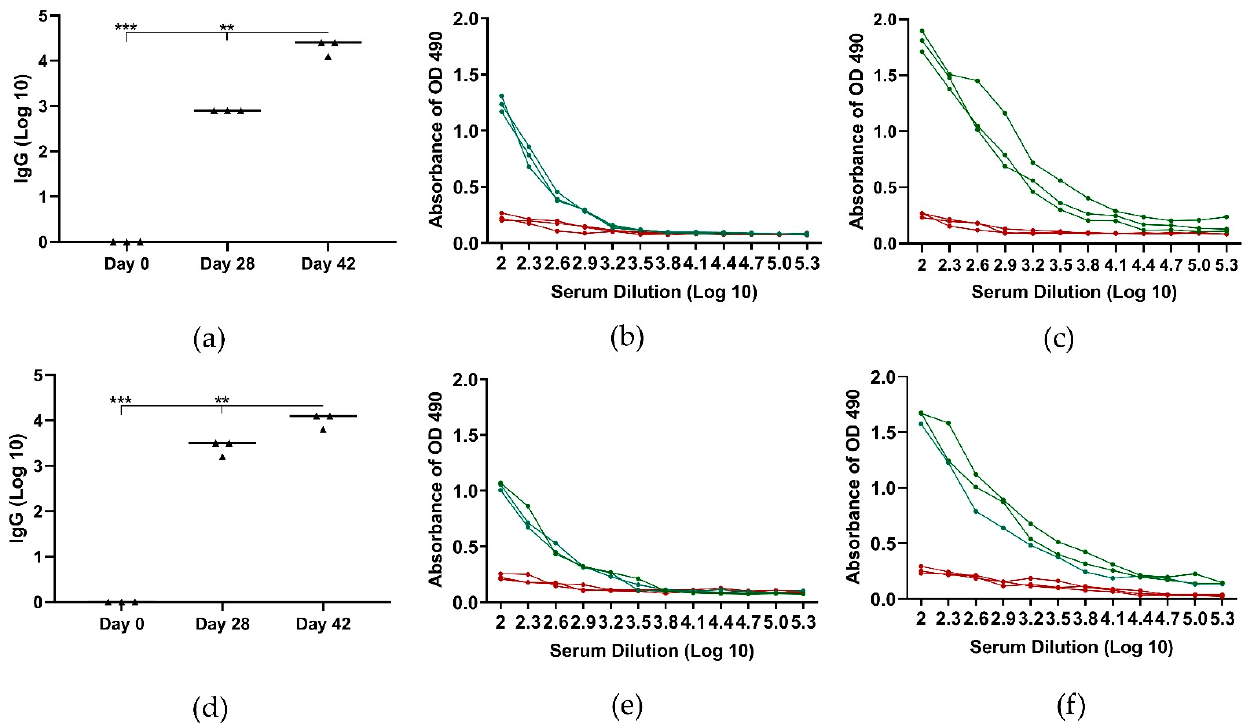
Figure 5. GnRH-specific antibody (IgG) response following intramuscular ( a – c ) and oral ( d – f ) administration of conjugate 2 in pigs: ( a ) GnRH-specific serum IgG titers before (day 0) and at day 28 and day 42; (**) p < 0.01, (***) p < 0.001. ( b ) optical density (OD) values from ELISA analysis of log serum dilutions at day 28; ( c ) OD values from ELISA analysis of log serum dilutions at day 42; ( d ) GnRH-specific serum IgG titers before (day 0) and two weeks after each oral immunization (day 28 and day 42); (**) p < 0.01, (***) p < 0.001. ( e ) OD values from ELISA analysis of log serum dilutions at day 28; ( f ) OD values from ELISA analysis of log serum dilutions at day 42. The green lines represent OD values of sera from immunized pigs, while the red lines are OD values of pig sera prior to immunization.